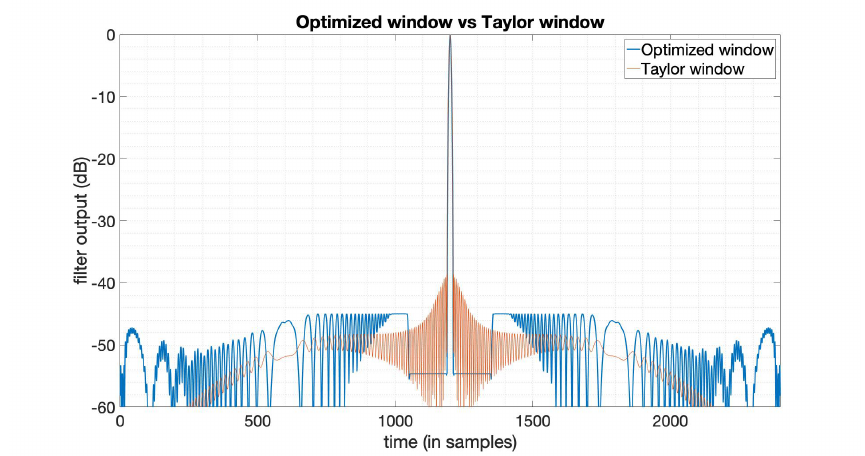
Figure 5. The output of the Taylor window (¯ n = 9,PSLR = − 40 dB) and the PSLR-optimized window with symmetric sidelobe gaps.